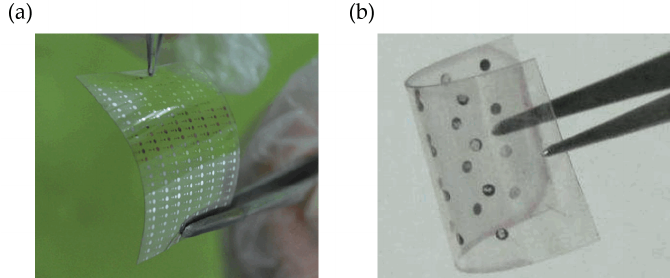
Figure 11. Illustration of GO ‐ based flexible RRAM devices with structures of ( a ) Al/GO/ITO/PET and ( b ) Al/Au/rGO/PVA NP/ITO/PET [148].